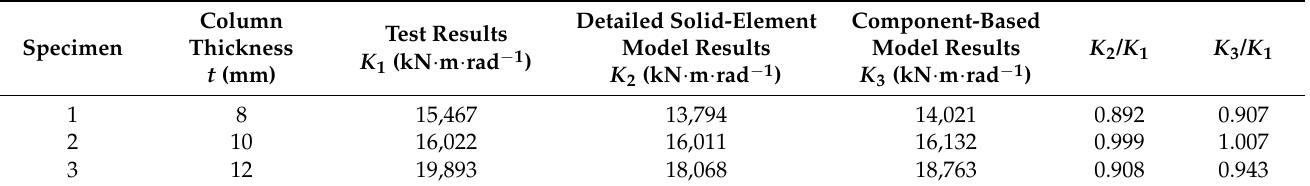
Table 4. Initial rotational stiffness of the test specimens, the detailed solid-element models, and the component-based